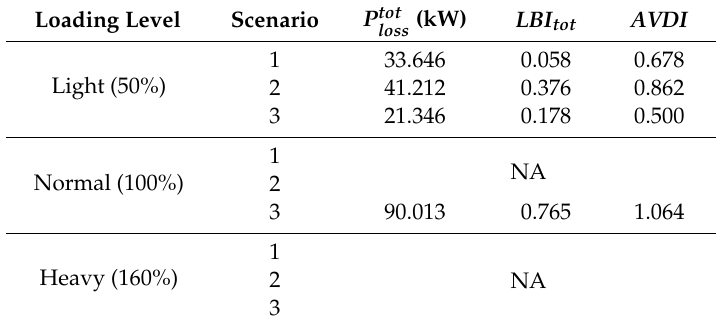
Table 2. Total power losses and PQ indices for scenarios 1, 2 and 3: IEEE 33-node